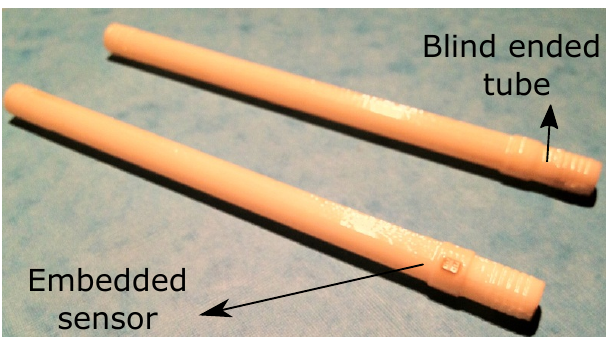
Figure 10. 3D printed tube used for physical leakage test.